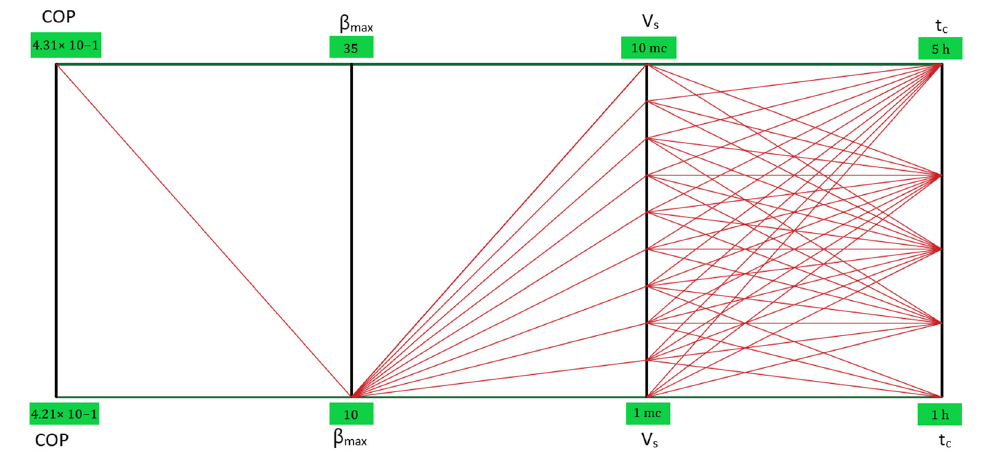
Figure 7. Parallel coordinate chart of the COP output variable in the optimized case.